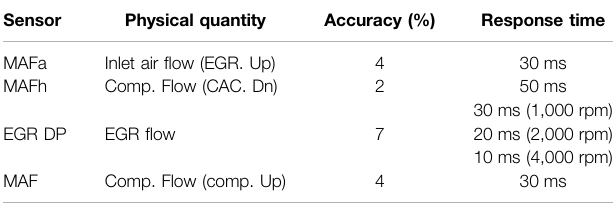
TABLE 1 | Available sensors.